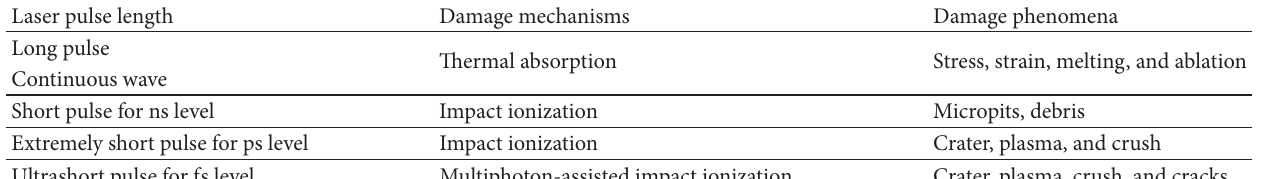
Table 1: The relationships between the pulse length of high power and LID of components.